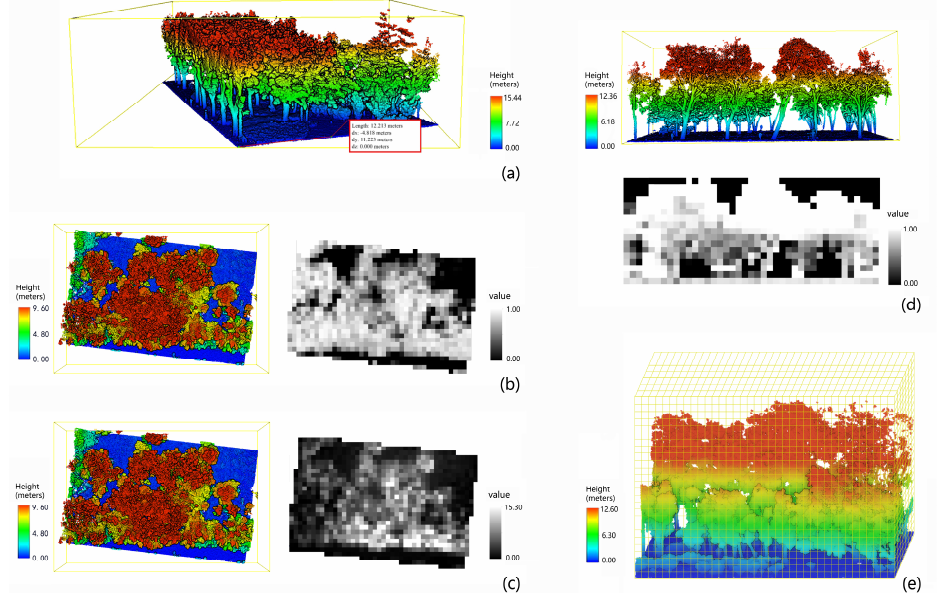
Figure 6. Index extraction content: ( a ) width, ( b ) coverage degree, ( c ) leaf area index, ( d ) horizontal occlusion degree, ( e ) percentage of point cloud grid.